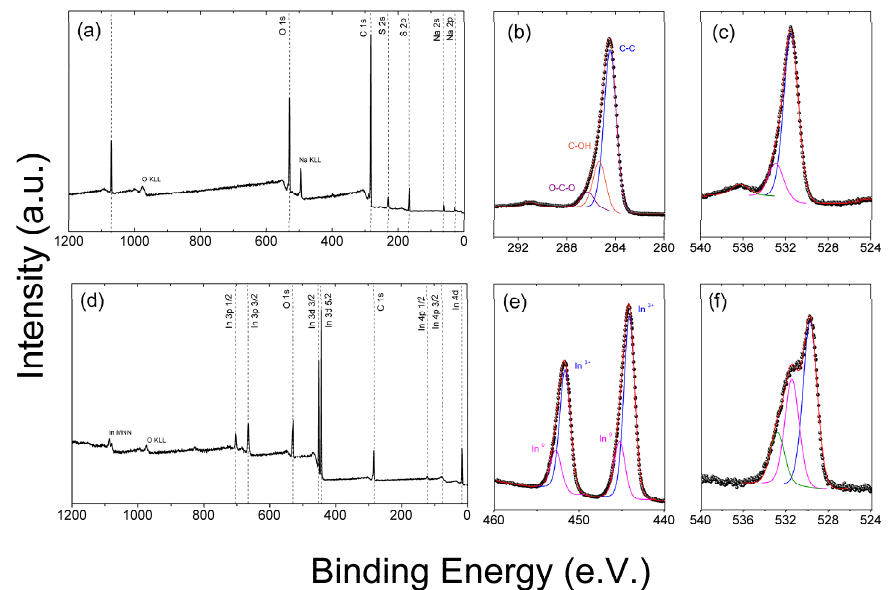
Figure 6. Typical X-ray photoelectron spectra of the commercial ( a – c ) rGO and synthesized ( d – f ) In 2 O 3 . ( a , d ) corresponds to survey spectra, ( b , e ) to high-resolution C 1s, and ( c , f ) to high-resolution O